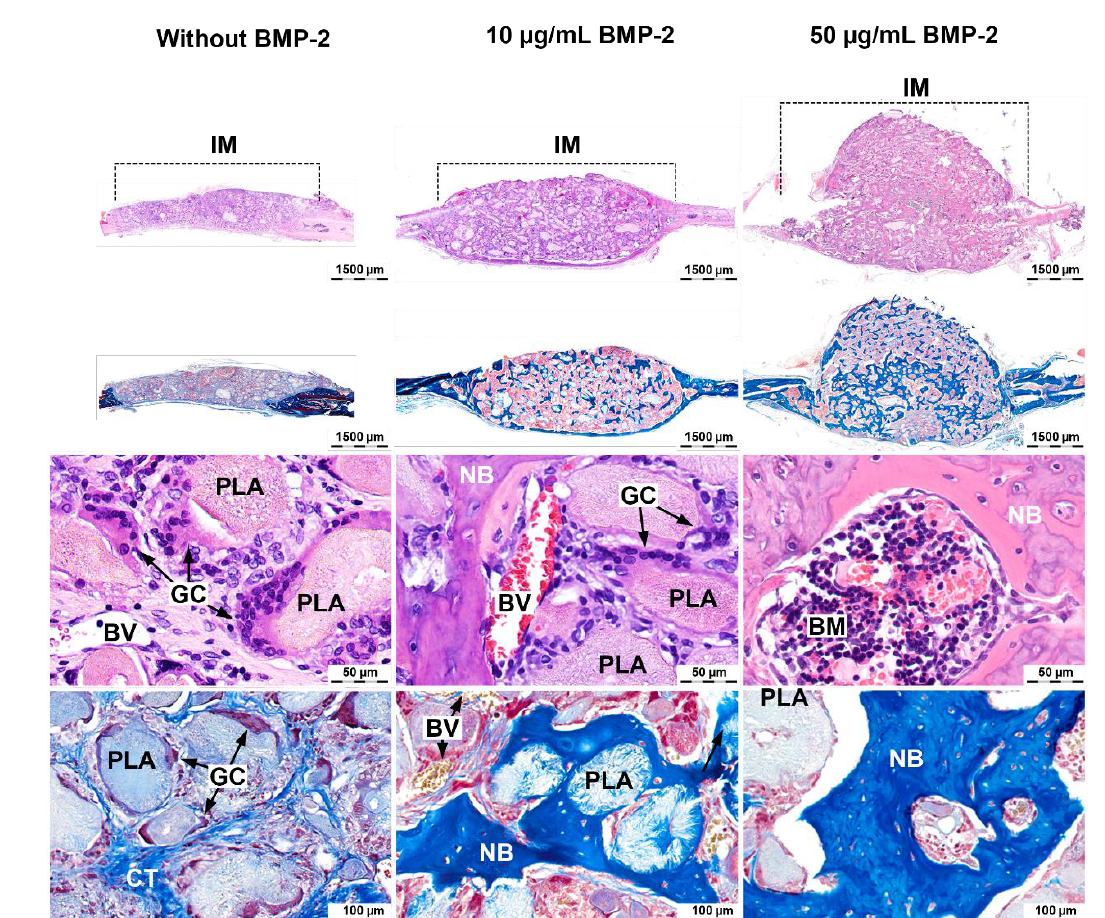
Figure 4. Bone regeneration capacity in the critical-size calvarial bone defect area of rats after implantation of the material based on the reacetylated chitosan/β-glycerophosphate hydrogel and 12 wt% PLA granules containing 0, 10, and 50 µg/mL of BMP-2. H&E and Masson’s trichrome staining after 28 days. PLA — highly porous polylactide granules, NB — newly formed bone, BV — blood vessel, GC — foreign-body giant cell, CT — connective tissue, IM — implanted material, and BM — bone marrow.